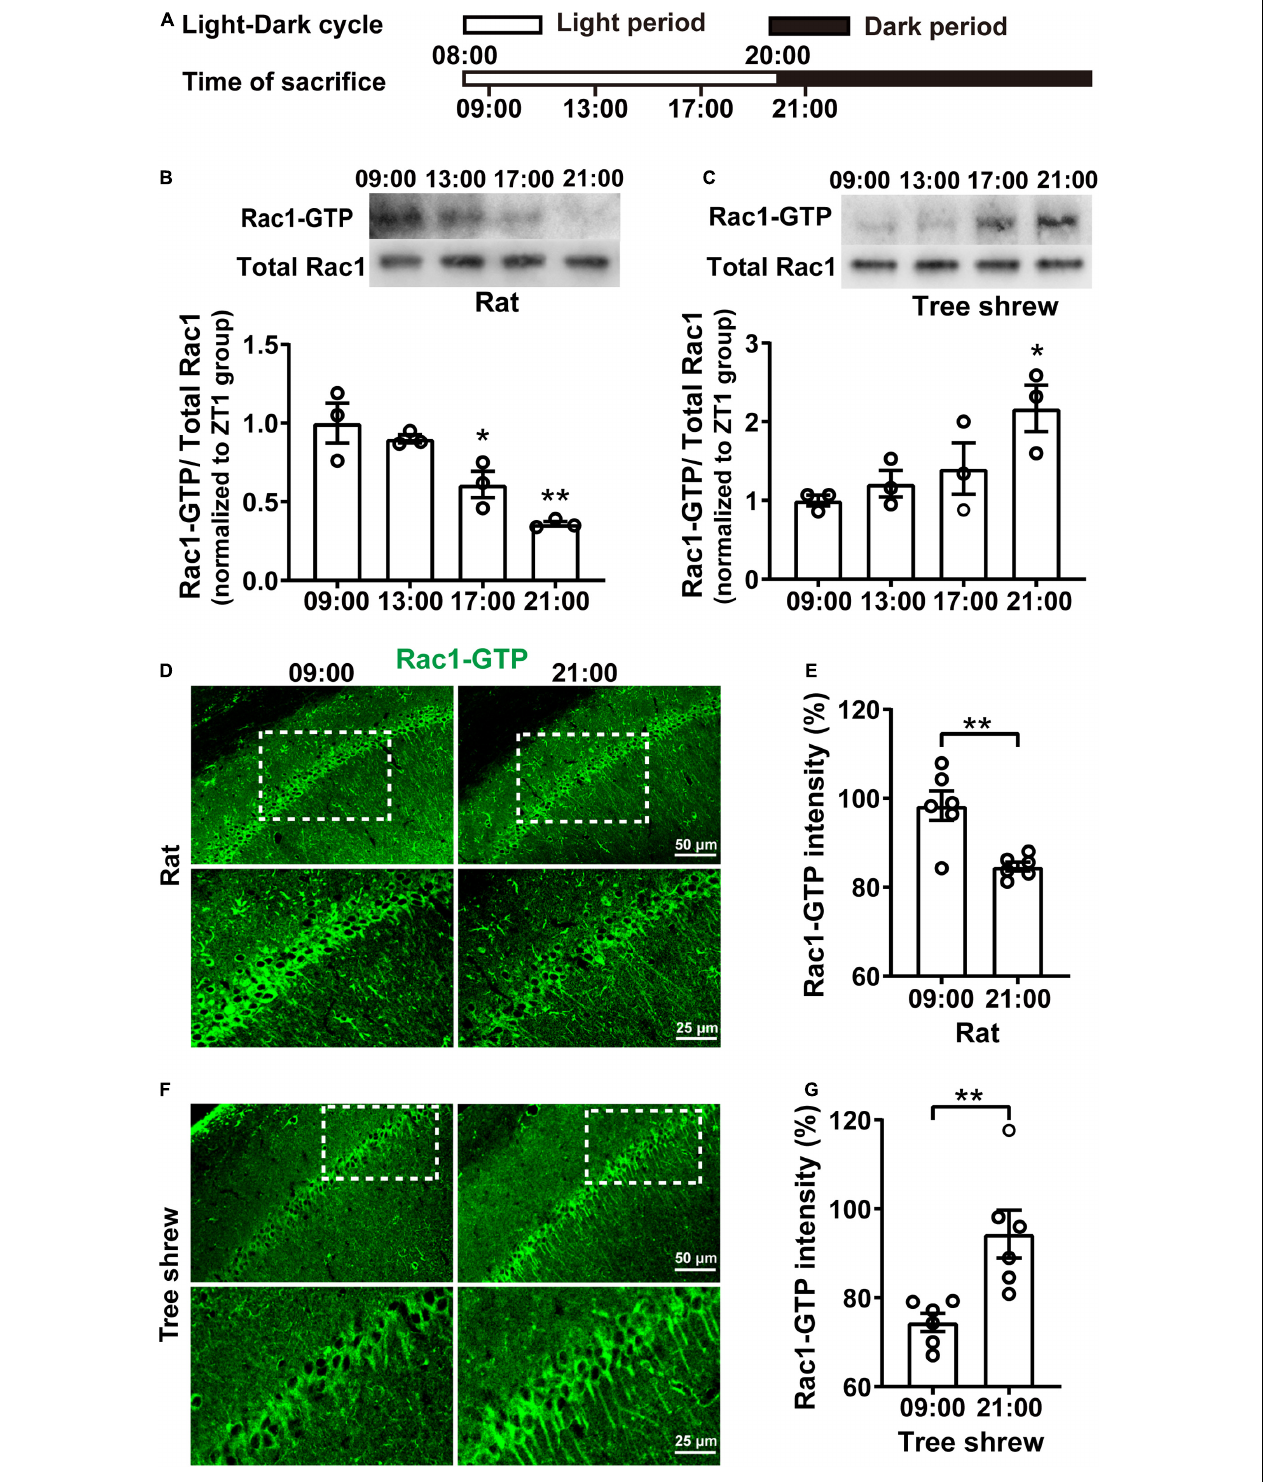
FIGURE 1 | Rac1 activity in the hippocampus shows fluctuates oppositely in nocturnal rats and diurnal tree shrews during the daytime. (A) Diagram for experimental procedures. The light was turned on at 08:00 and turned off at 20:00. Rats and tree shrews were sacrificed at 09:00, 13:00, 17:00, or 21:00. (B) Rac1 activity in the hippocampus shows gradually decreased from 09:00 to 21:00 in rats. Upper panel: representative WB demonstrated that Rac1 activity sharply decreased at the 17:00 and 21:00 groups compared with the 09:00 group. Lower panel: statistical bar graph showed an obvious inhibition of Rac1-GTP in the 17:00 group and 21:00 group compared with the 09:00 group. (C) Rac1 activity in the hippocampus shows gradually increased from 09:00 to 21:00 in tree shrews. Upper panel: